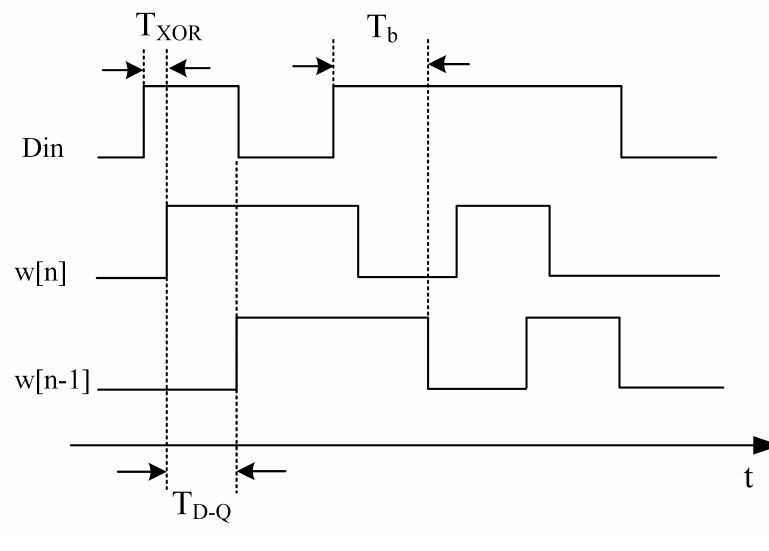
Figure 4. Sequence diagram.